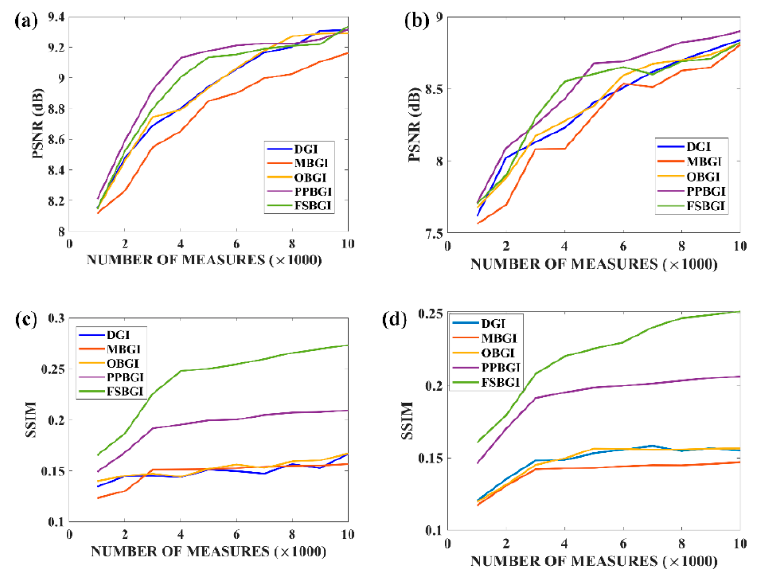
Figure 5. The quantitative comparison of reconstruction results by different methods. ( a ) The PSNRs of reconstructed Chinese character with different methods changing with the number of measurements. ( b ) The PSNRs of reconstructed image panda with different methods changing with the number of measurements. ( c ) The SSIMs of reconstructed Chinese character with different methods changing with the number of measurements. ( d ) The SSIMs of reconstructed image panda with different methods changing with the number of measurements.